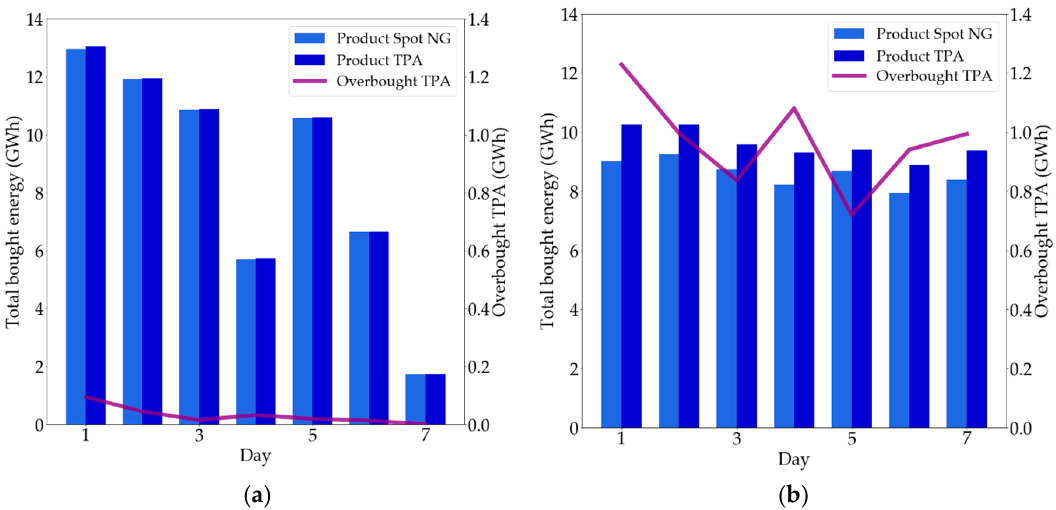
Figure 14. Relationship among spot natural gas product and access capacity ( a ) with a gas storage and ( b ) without gas storage. ( b ) without gas storage.